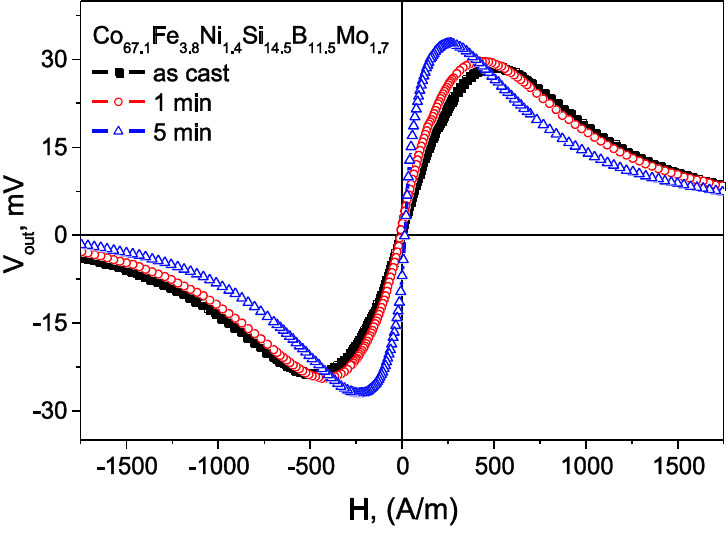
Figure 11. V 50 mA currents for different time [3].